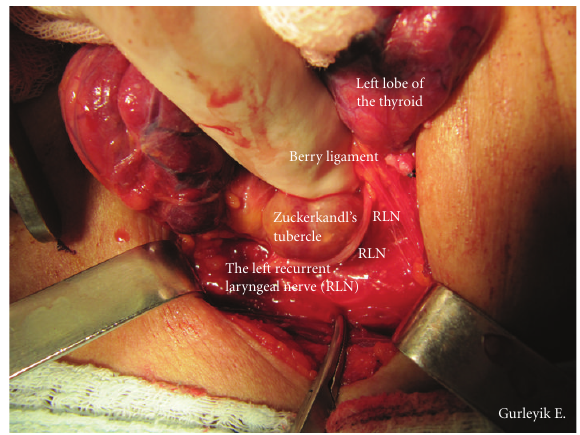
Figure 2: A grade 3 Zuckerkandl’s tubercle (Case 2) displaced the right RLN laterally.